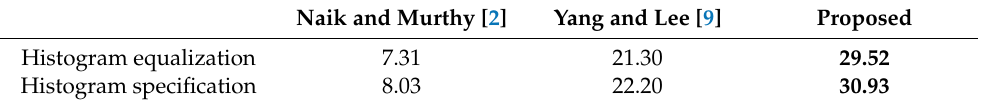
Figure 15. Mean saturation of enhanced images in Figures 13a and 14b, where the vertical axes denote the mean saturation, and the horizontal axes denote the image ID numbered in Figure 12. The yellow, orange and red bars denote Naik and Murthy’s method, Yang and Lee’s method and the proposed method, respectively. The error bars denote the standard deviation of saturation. Table 3. Standard deviation of saturation, where the maximum value in each row is indicated in boldface.